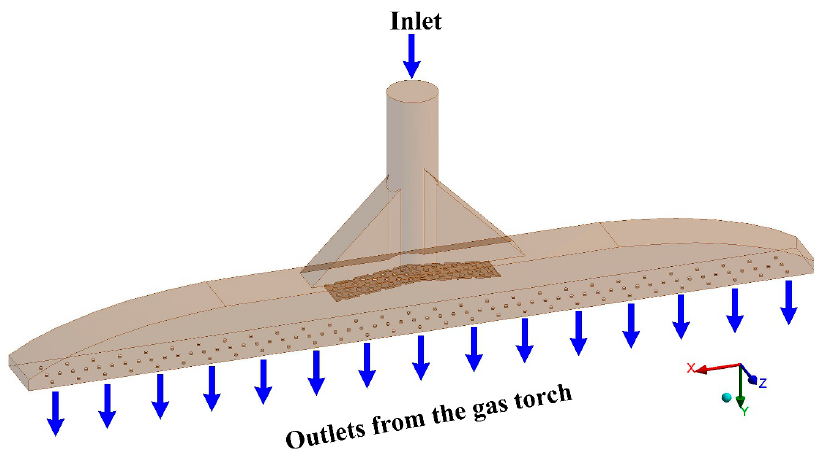
Figure 2. Three-dimensional gas torch model.